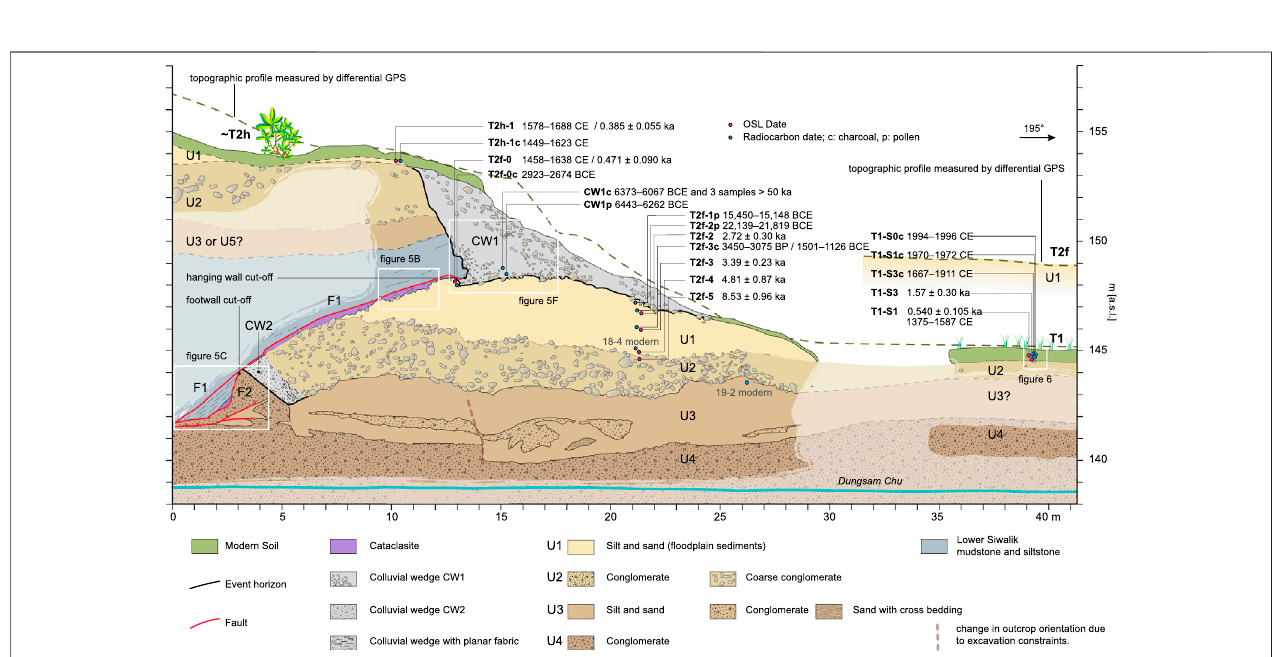
FIGURE 4 | Detailed map of the Dungsam Chu palaeoseismic exposure. This map is a projection of the photomosaic ( Figure 3 ) into the kinematic plane, perpendicular tothetrace ofthefaultand paralleltotheslickenlinesobservedalongtheclaysmears withintheF1 surface.Themap wasconstructed byobservations on the photomosaic, individual photographs, and by fi eld observations. The topographic pro fi le, including the surface of T1 and T2f to the south of the MFT trace, were measuredbyadGPS. ThedGPSmeasurementsweremadealongtheslope,awayfromthecliffedge,andareslightlyhigher.Thetopographicpro fi leandT2fwere projected onto the map of the exposure. The Dungsam Chu bed is also measured by the dGPS (darker blue segment on Figure 2B ). Faded colors indicate a lack of exposure.